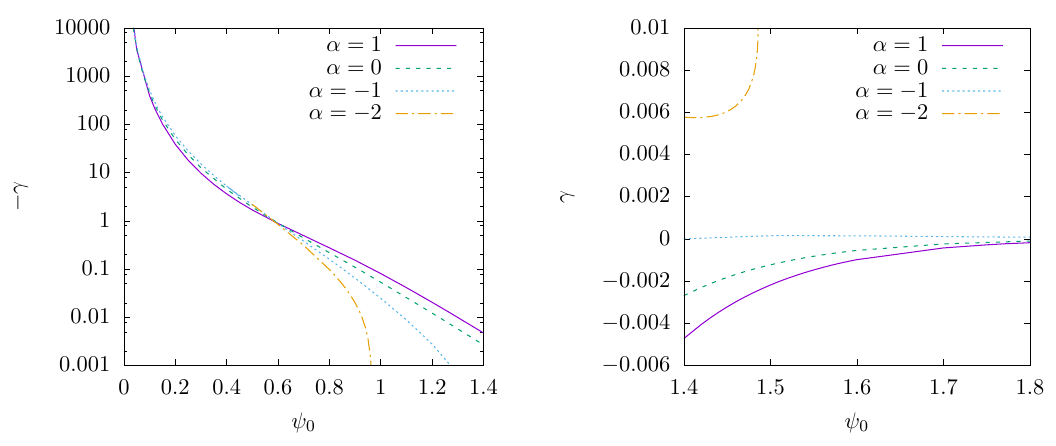
1. For clarity, we indicate ≡